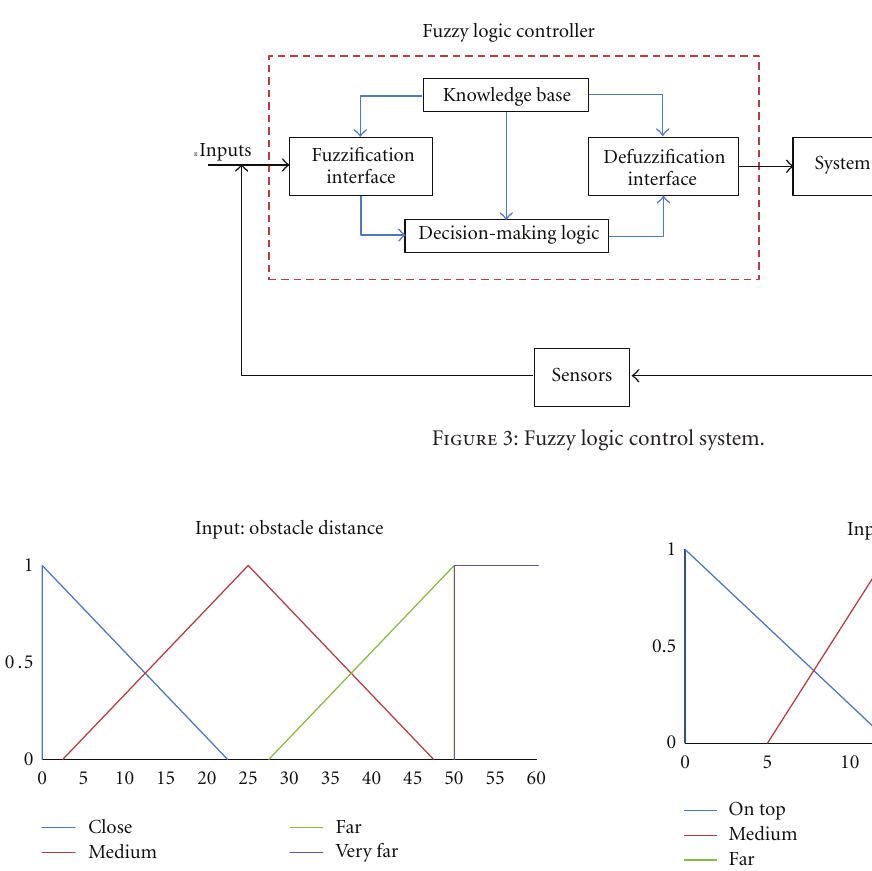
Figure 4: Input: distance between obstacle and agent (very far is for an obstacle out of sensing range).